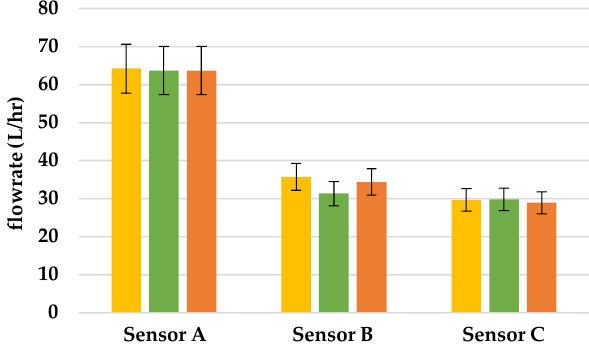
Figure 10. Flowrate of sensors when there is 5.28 cm 2 leakage in the pipeline.